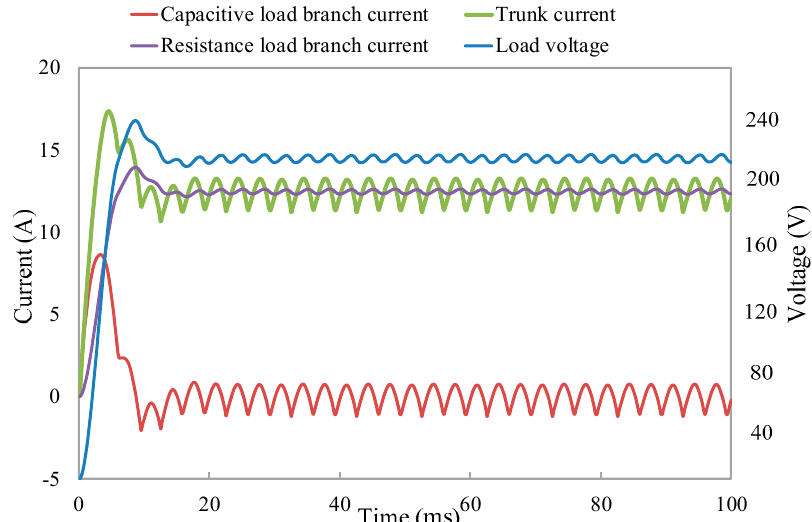
Figure 8. The load current and voltage of Pulse Width Modulation (PWM) rectifier circuit.